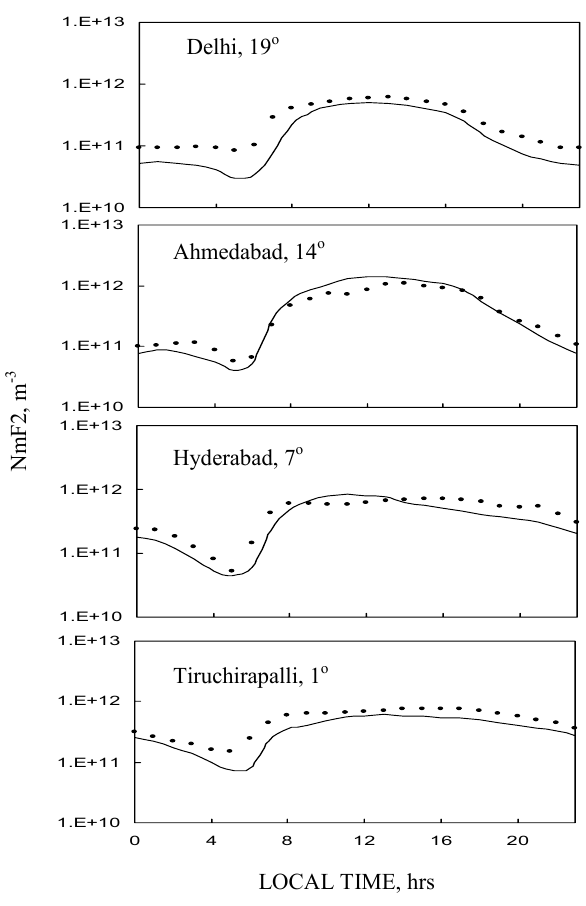
Fig. 3. Measured and simulated Nm F2 (shown by dots and solid line, respectively) for selected locations along 75 ◦ E meridian. The dots are averages of all data for the December solstice solar mini- mum conditions during